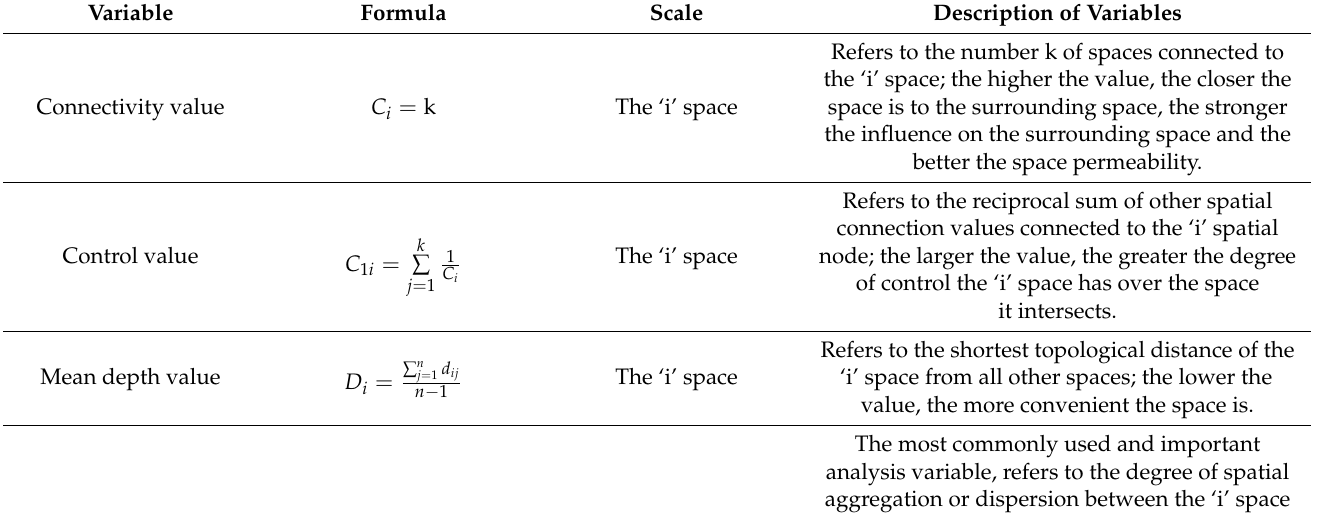
Table 2. Formula and description of analysis variables in space syntax model (Duan, J. & Hillier, B. 2007. Urban Space 3: Space Syntax and Urban Planning, Nanjing, Southeast University